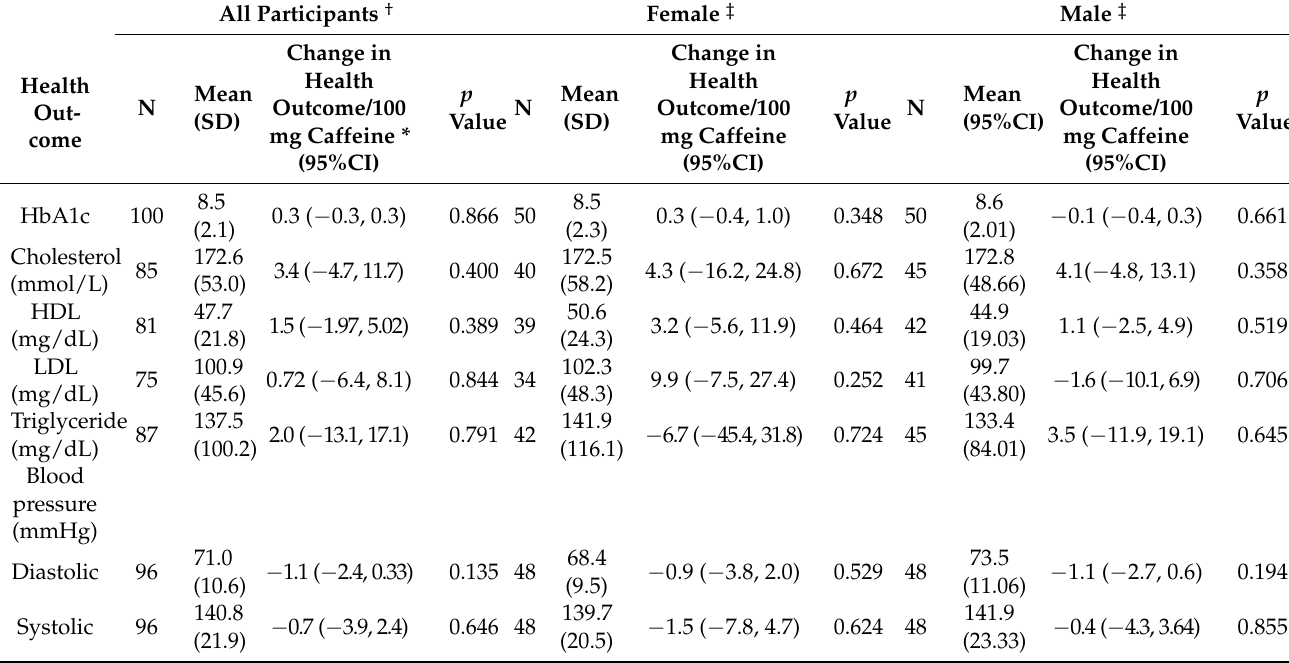
Table 3. Association between caffeine intake (100 mg/day) and HbA1C, cholesterol, triglyceride, and blood pressure for all participants and clustering by